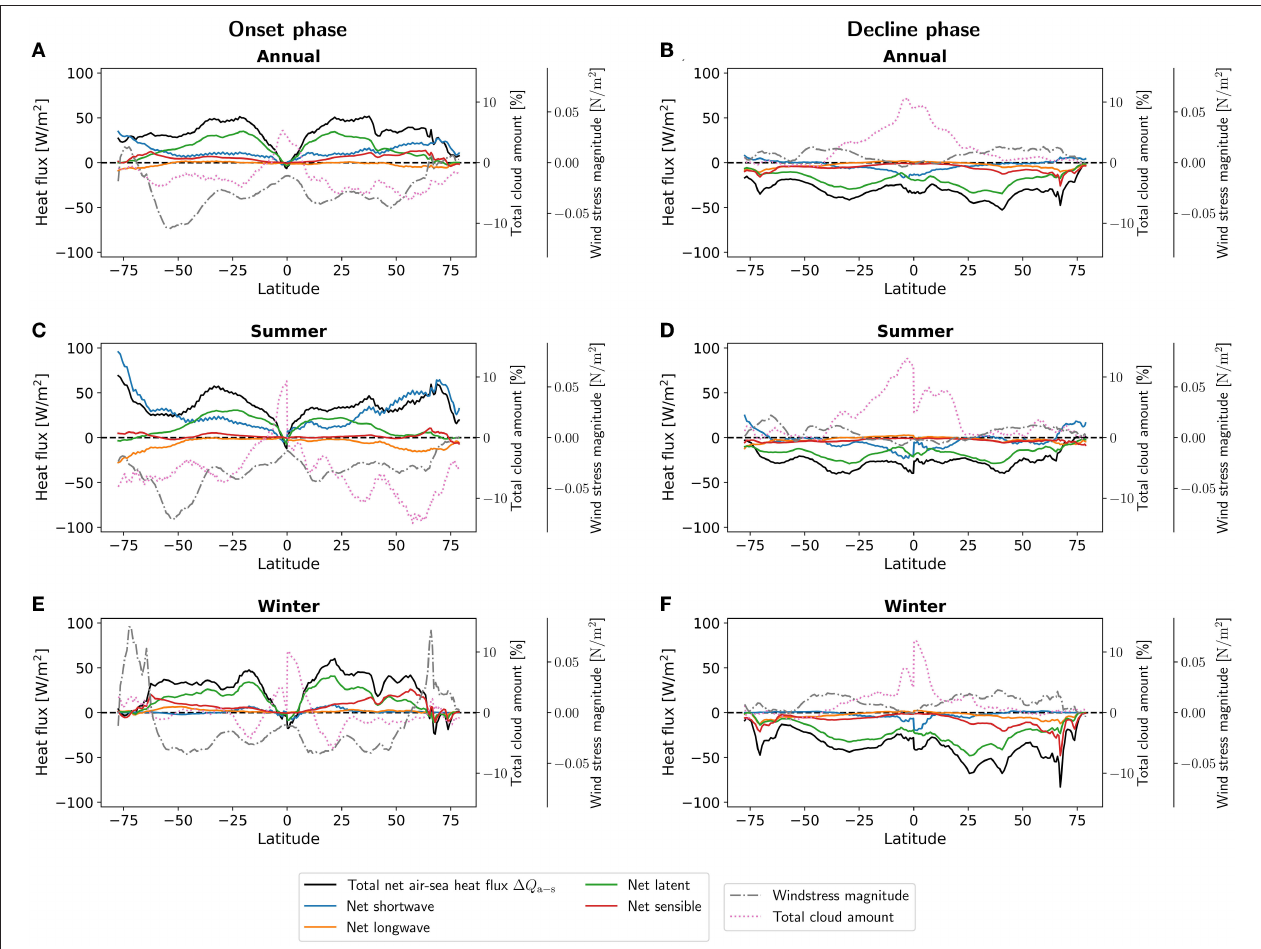
FIGURE 4 | Individual contributions to air-sea heat flux anomalies during marine heatwave onset and decline for the annual mean (A,B) , summer (C,D) , and winter (E,F) season. Shown are zonal mean air-sea heat flux anomalies 1 Q a-s , as well as the air-sea heat flux component anomalies (shortwave and longwave radiation, latent and sensible heat fluxes), wind stress magnitude anomalies, and total cloud amount anomalies. The summer and winter panels show the anomalies averaged over the respective season in both hemispheres simultaneously. For summer, the panels use JJA for the Northern Hemisphere and DJF for the Southern Hemisphere. For winter, the panels use DJF for the Northern Hemisphere and JJA for the Southern Hemisphere. The climatological mean state for these terms in the annual mean and during summer and winter is given in Supplementary Figure 2